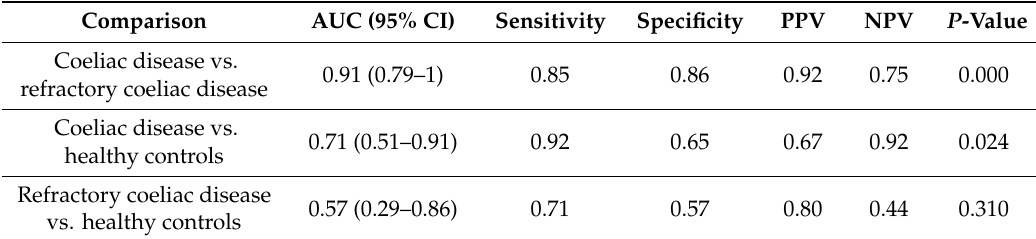
Table 2. Differences in faecal volatile organic compounds between patients with coeliac disease, refractory coeliac disease and healthy controls.